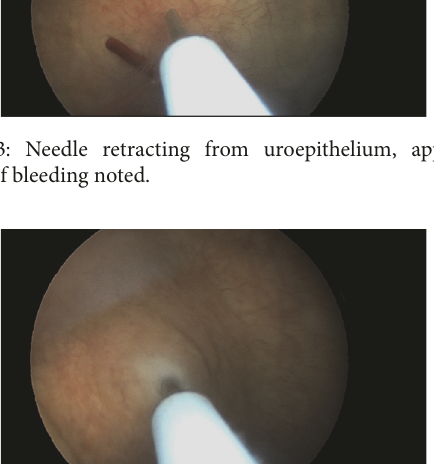
Figure 4: Needle replaced into uroepithelium.